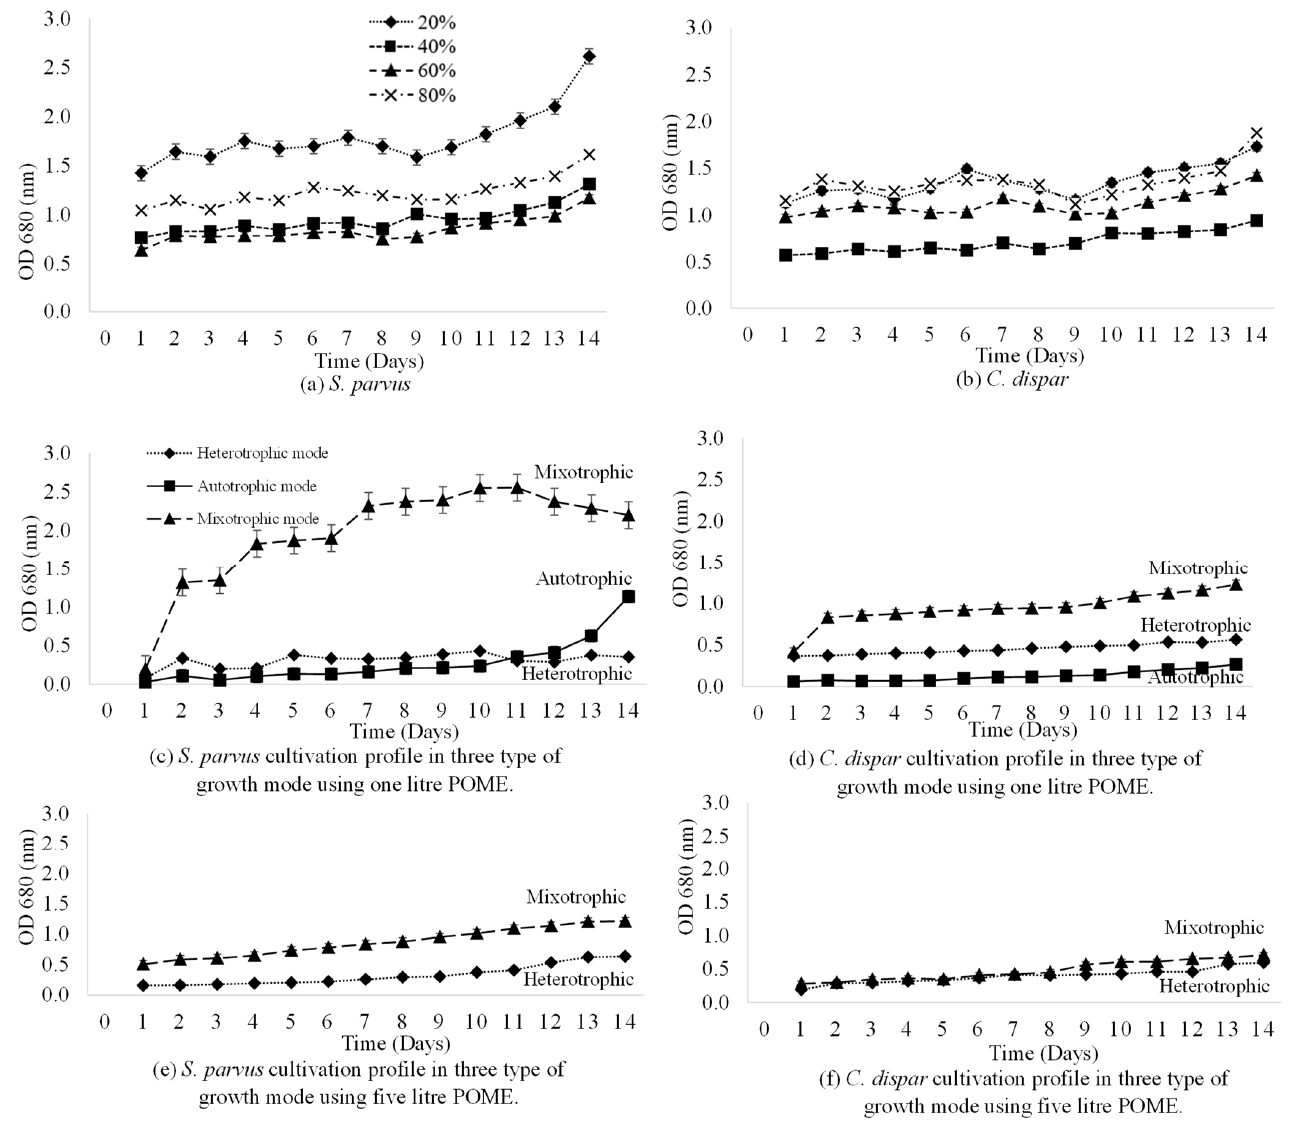
Figure 2. Scenedesmus parvus and Coccomyxa dispar cultivation profiles with ( a , b ) various concentra- tions of microalgae (20%, 40%, 60%, 80%) and ( c – f ) POME working volumes of 1 and 5 L.